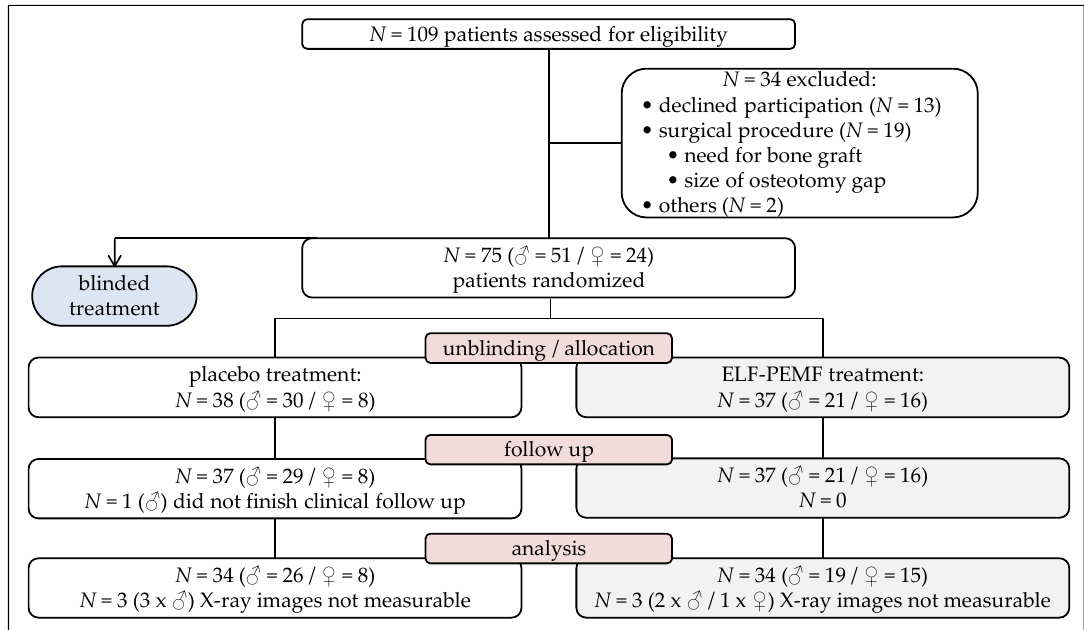
Figure 2. Flow diagram on patient recruitment and study population.